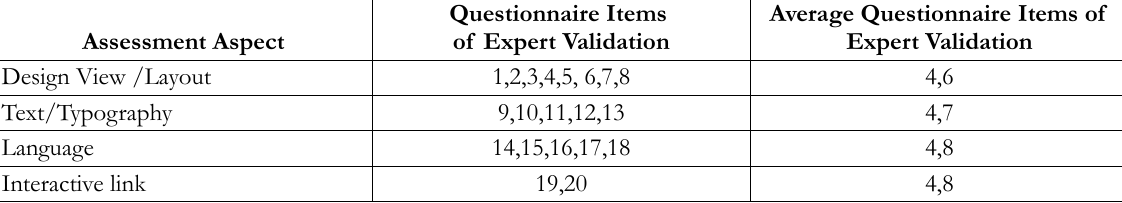
Table 5. Results of expert validation Integrated STEAM Project for Mobile